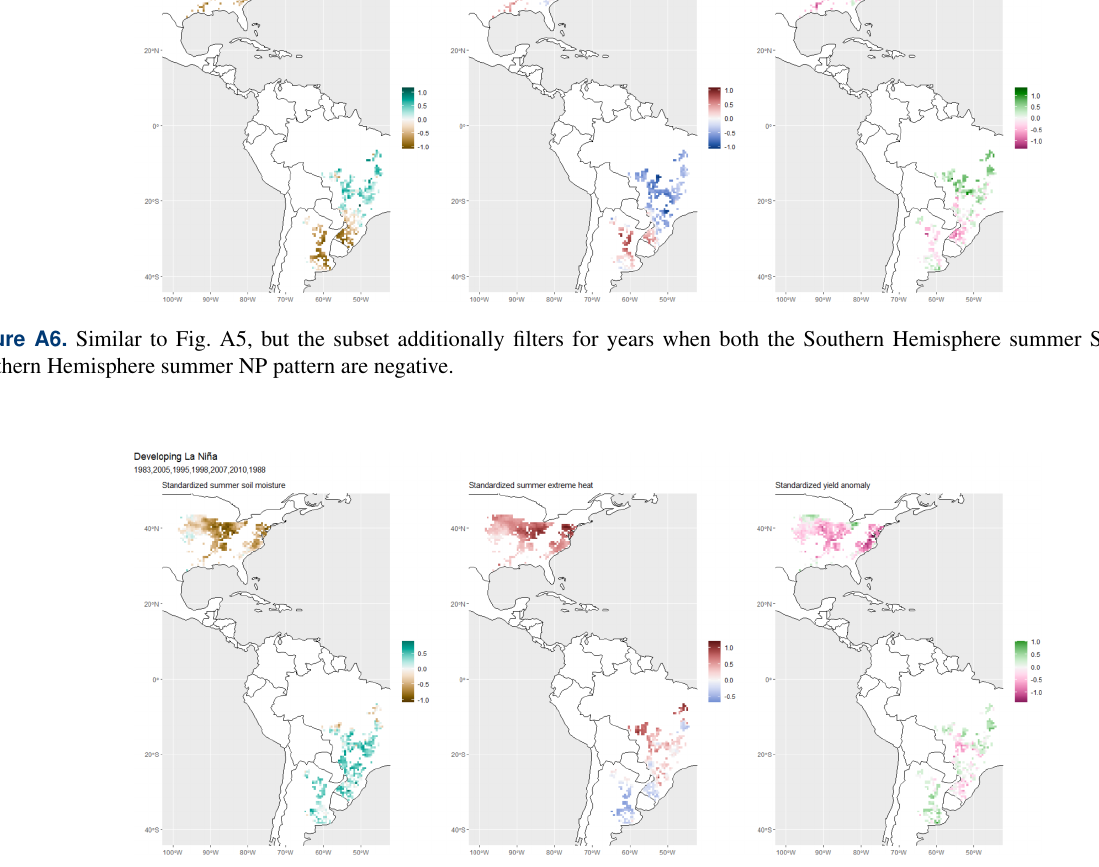
Figure A7. Similar to Fig. A5 but considering developing La Niña years as per Jong et al. (2020).